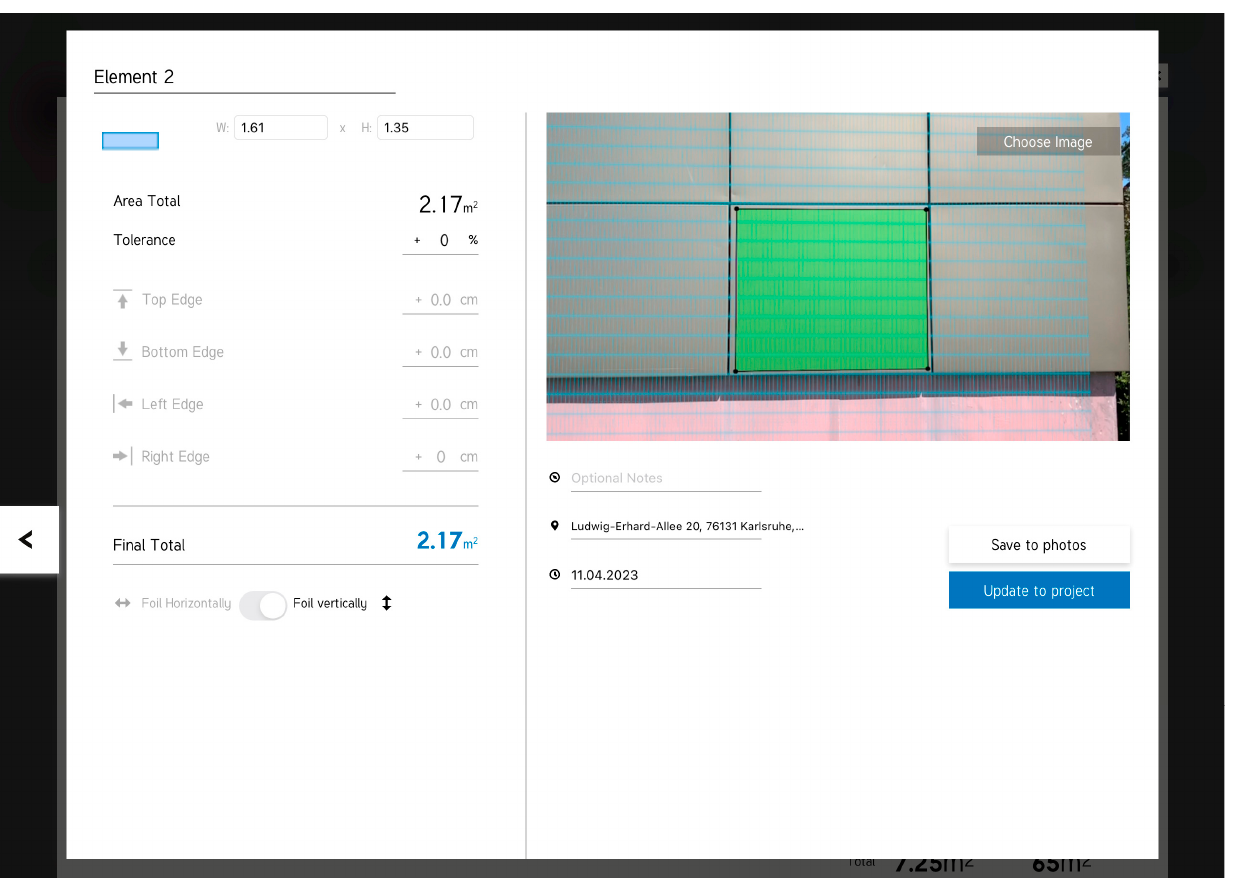
Figure 4. Application scenario showing the post-processing of acquired data from an AR application collecting measurements (industrial project